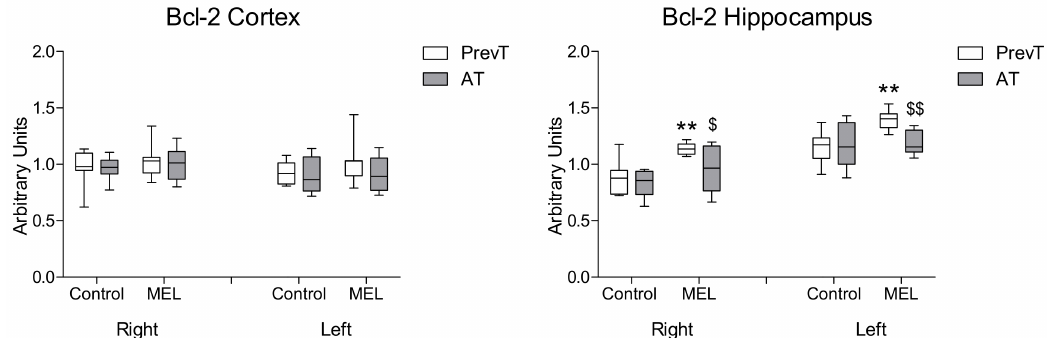
Figure 6. Right and left cortical and hippocampal mRNA expression of Bcl-2 in 18-month-old rats in control (non-treated) conditions, after treatment with a daily dose of melatonin (10 mg/kg b.w.) from 24 h before until 7 days after surgery (PrevT), and treated only after surgery during 7 days (AT). Each value represents the median, interquartile and full range of five determinations performed in duplicate. ** p < 0.01 with respect to the values obtained in the control group; $ p < 0.05 with respect to the values obtained in the PrevT group; $$ p < 0.01 with respect to the values obtained in the PrevT